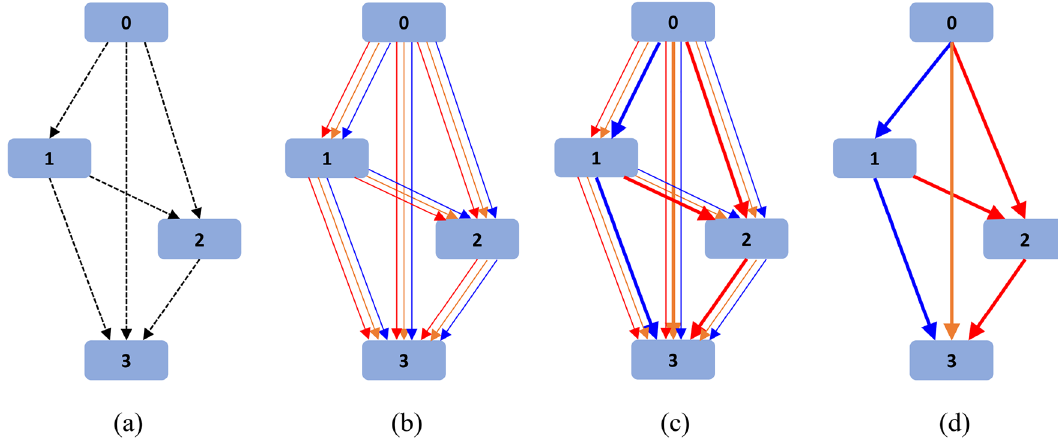
Figure 2. Searching process of cell architecture using DARTS.